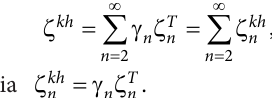
Fig. 1. Deformations of surfaces due to the Moon effect ( n = 2)